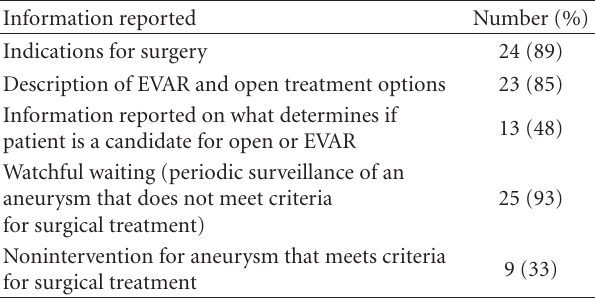
Table 2: Treatment options and